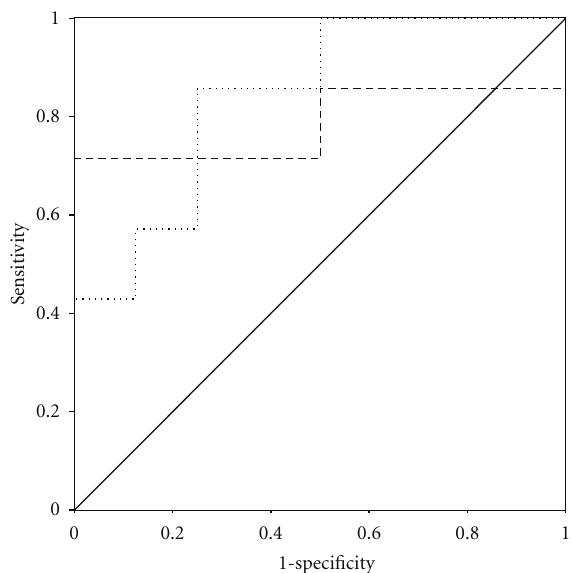
Figure 3: ROC curve for ADMA (long dashed line) and L-arg (short dashed line) plasma levels at sepsis onset in patients with septic shock and an accompanying ALF who ultimately did ( n = 8) and did not ( n = 7) survive within the 28 days observation